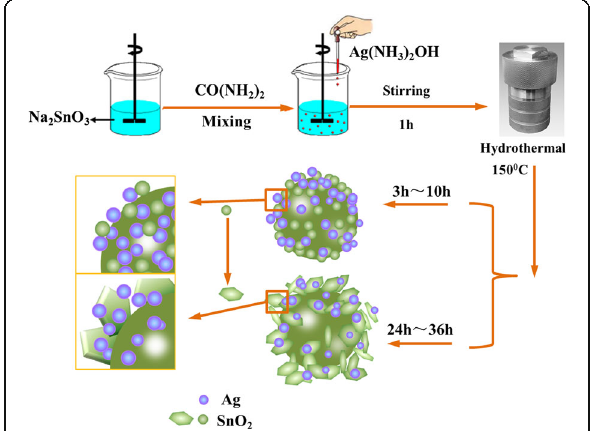
Fig. 9 Schematic illustrations of the synthesis of